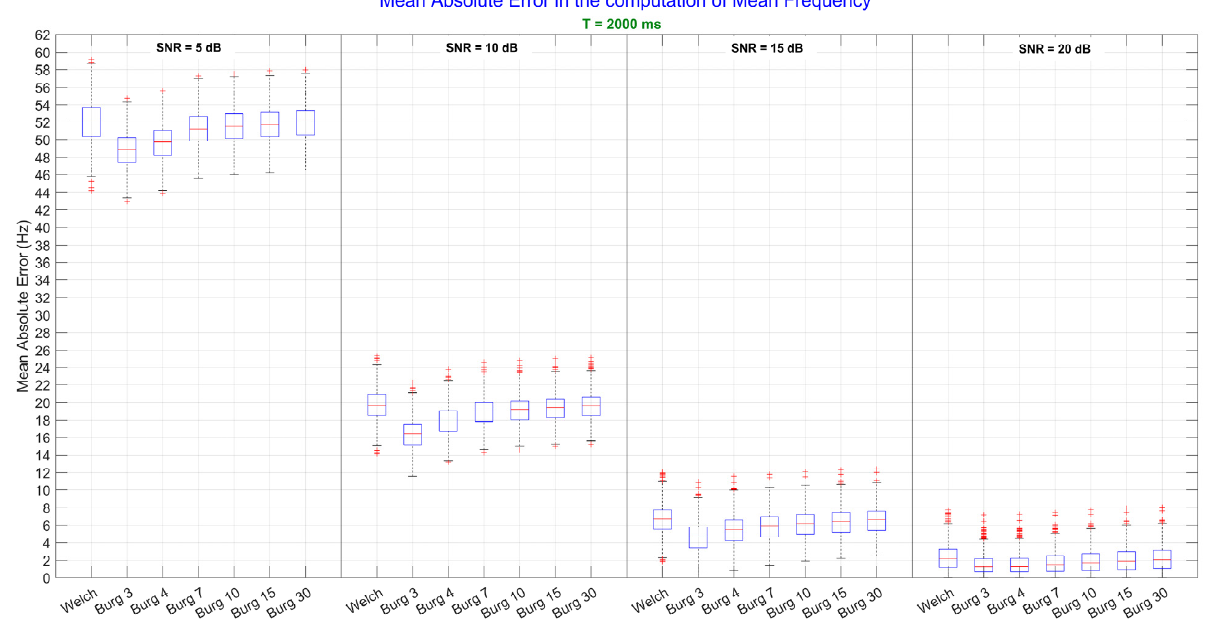
Figure 3. Mean frequency values computed from the power spectral density, which were estimated by Welch and Burg methods. The analysis performed on long signals (T = 2000 ms) is shown. In each subplot, a specific level of Signal-to-Noise Ratio (SNR) is represented. Since one-way ANOVA on the method factor was significant, post-hoc tests were performed: the significance level was set at p < 0.05